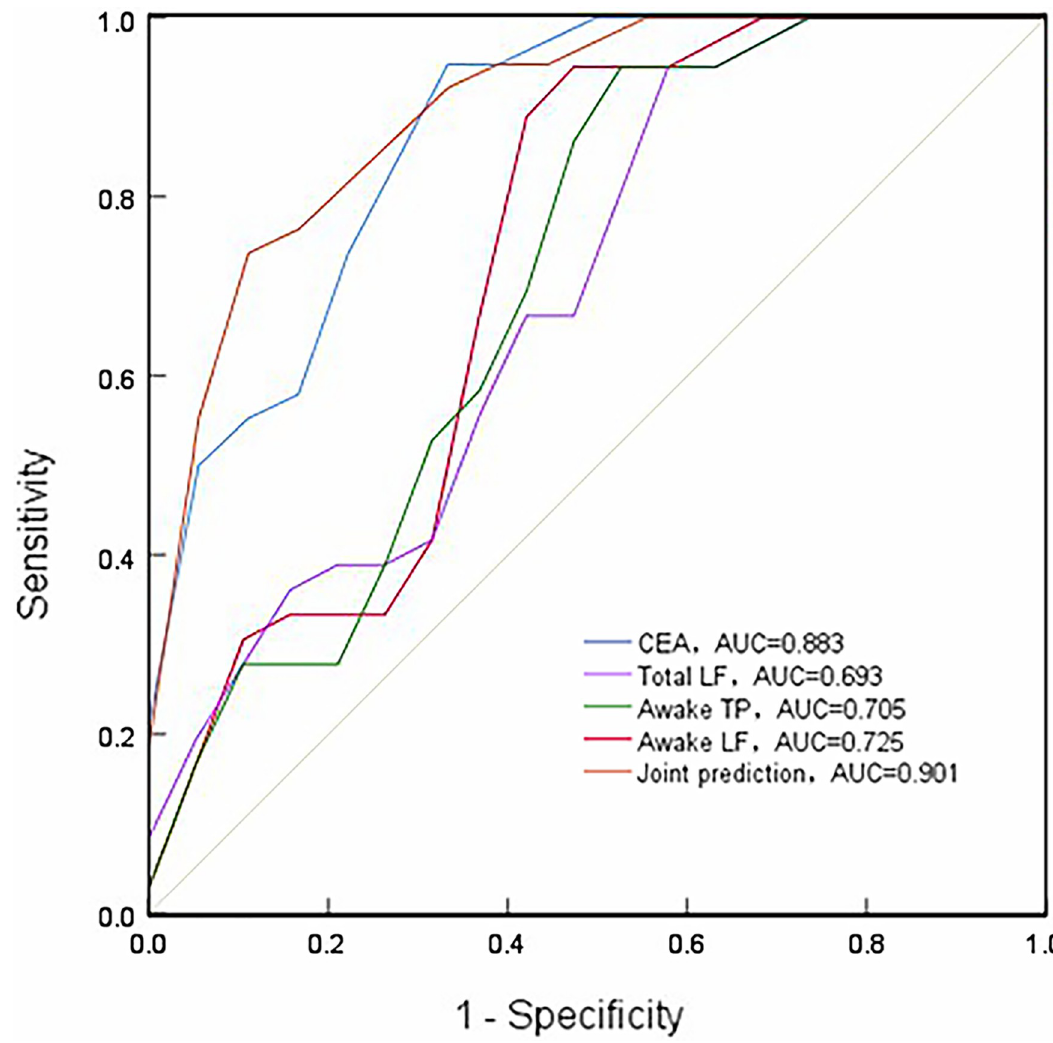
Fig 4. Receiver operating characteristic (ROC) curves for HRV parameters and CEA. Joint prediction, combined awake TP, awake LF and CEA; AUC, area under the ROC curve.